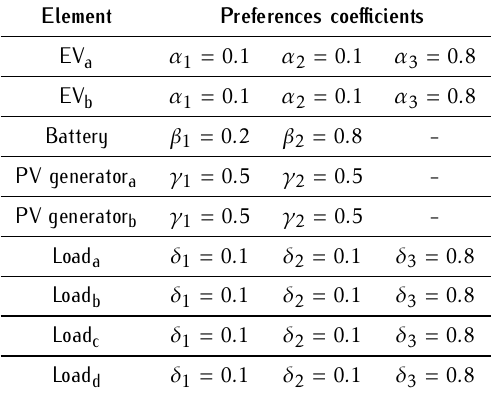
Table 1. Parameters of grid elements for scenario (a)